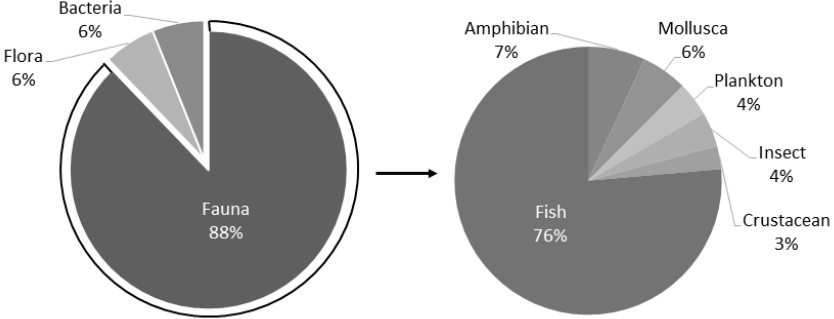
Figure 11. Aquatic organisms analyzed in the studies .